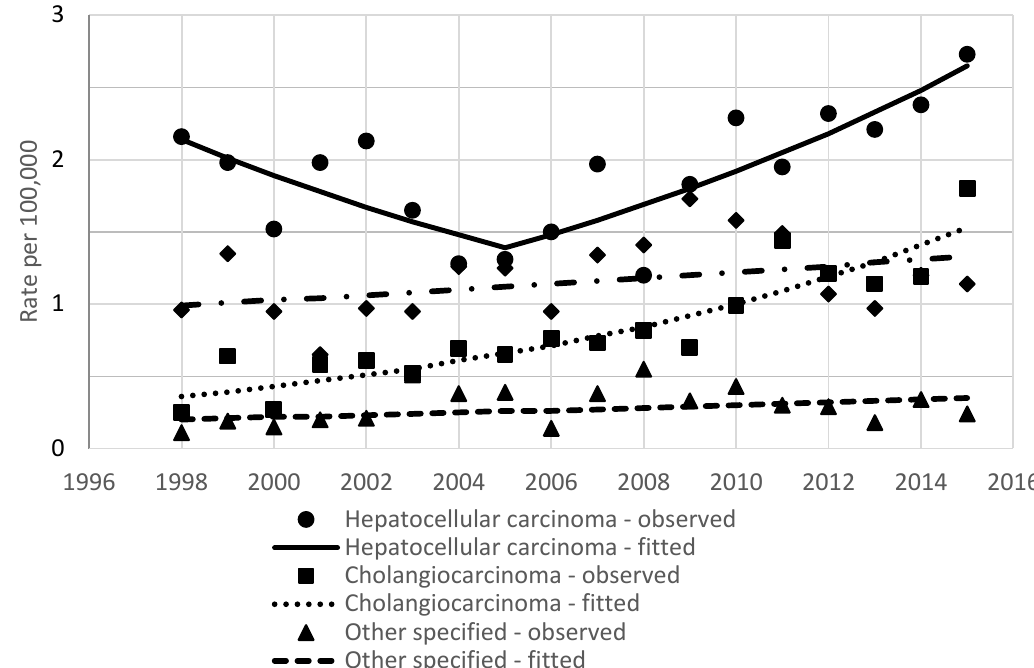
Figure 3. Age-standardized incidence rates of primary liver cancer by histology in Lithuania between 1998 to 2015.